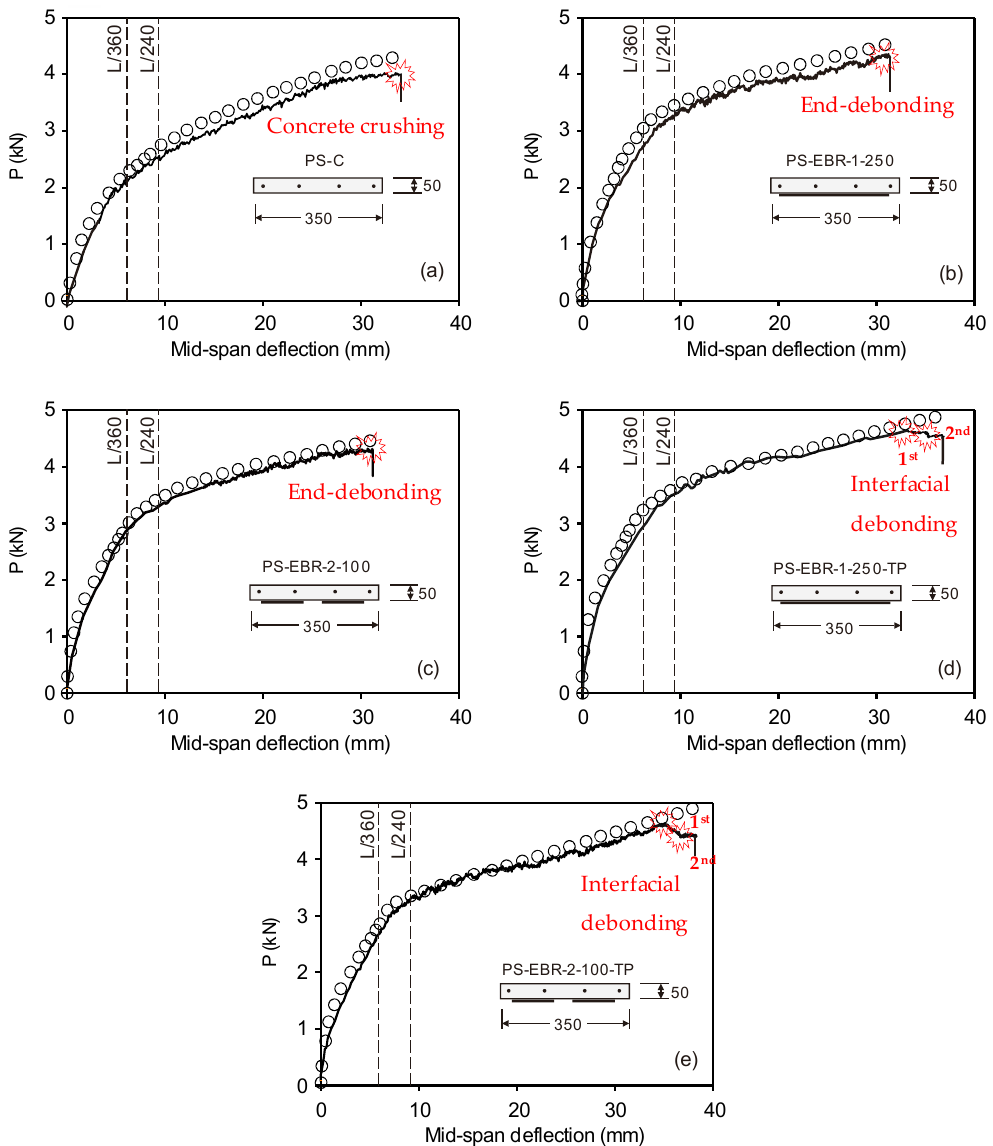
Figure 8. Comparison of experimental load-deflection and numerical predictions. ( a ) PS-C; ( b ) PS- EBR-1-250; ( c ) PS-EBR-2-100; ( d ) PS-EBR-1-250-TP; ( e )